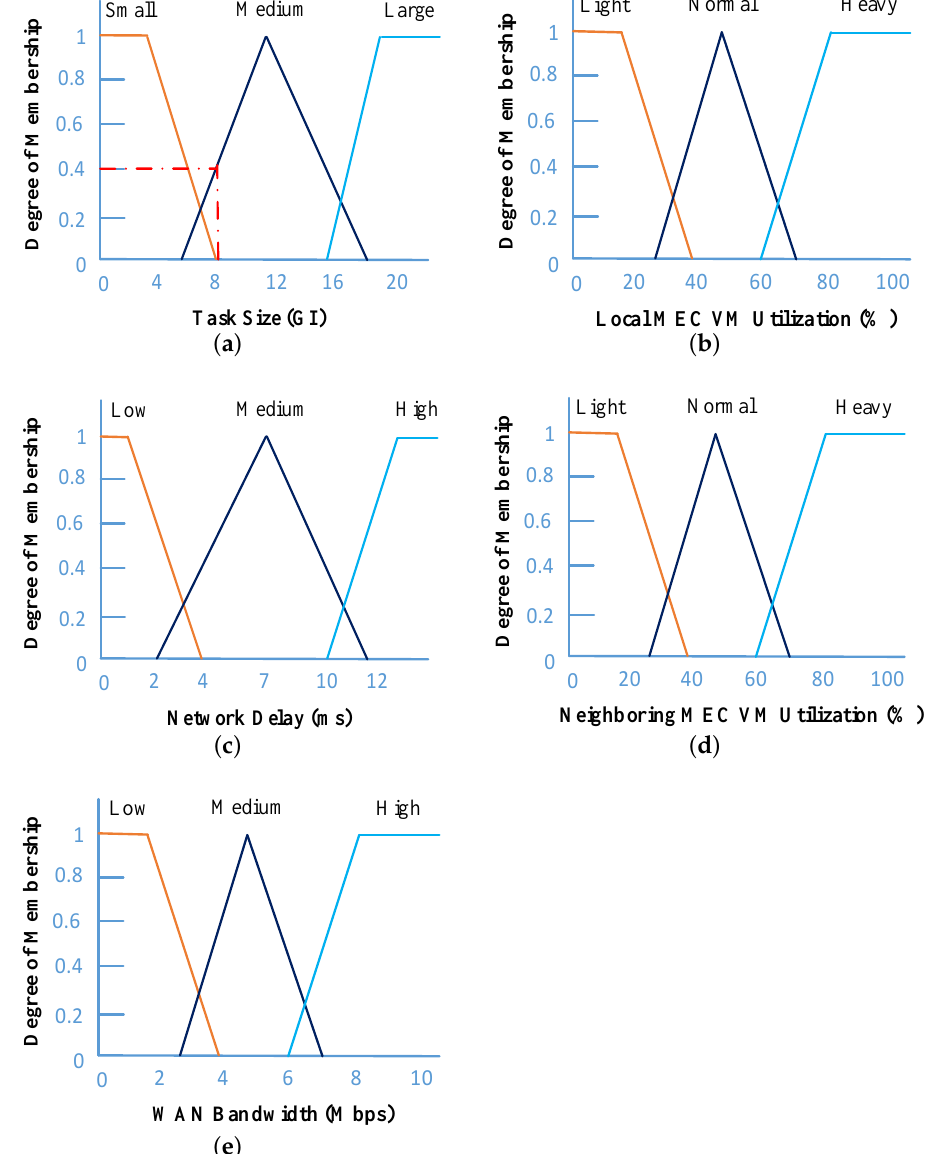
Figure 8. Membership functions (MFs) for the fuzzy input variables: ( a ) task size; ( b ) local MEC VM utilization; ( c ) network delay; ( d ) neighboring MEC VM utilization; ( e ) WAN